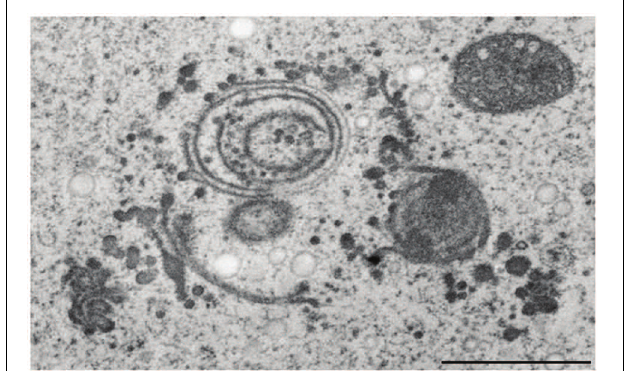
FIGURE 9 | Transmission electron microscopy micrograph of abnormal cluster of dictyosomes induced by treatment of Micrasteria s with CdSO 4 . Scale bar 1 µ